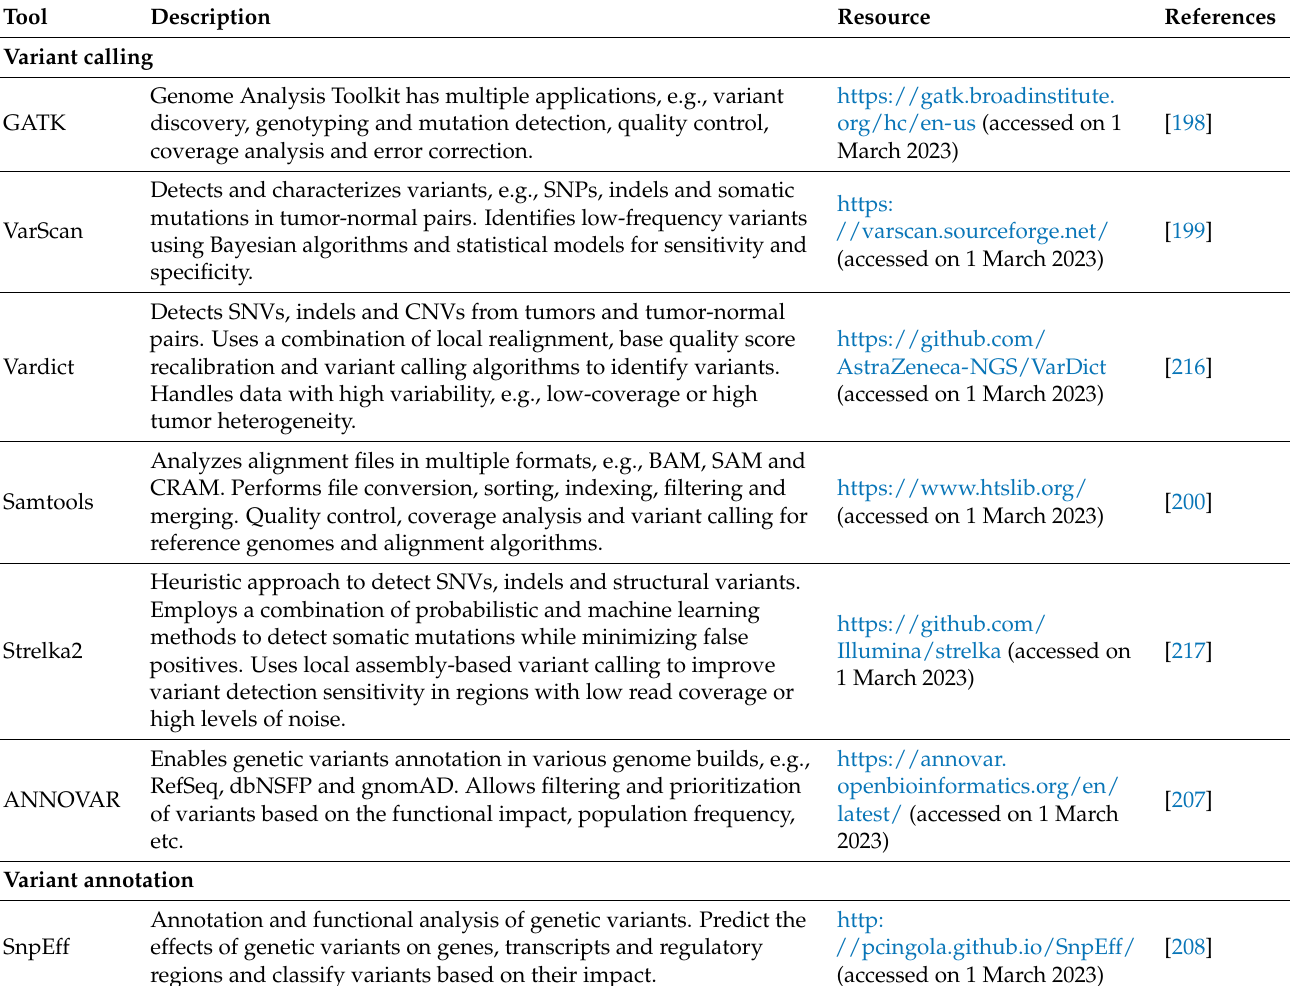
Table 2. Tools for computational analysis of NGS